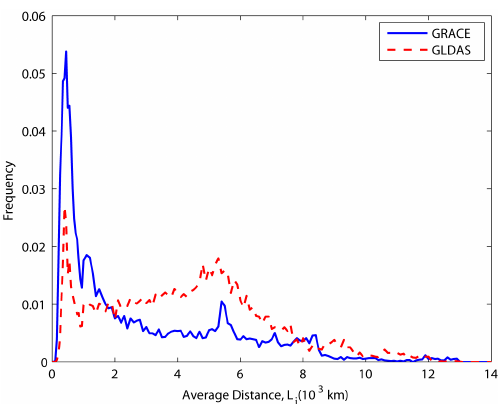
Figure 8. Distribution of average edge lengths in GRACE and GLDAS networks, where L i denotes the average distance between node i and its